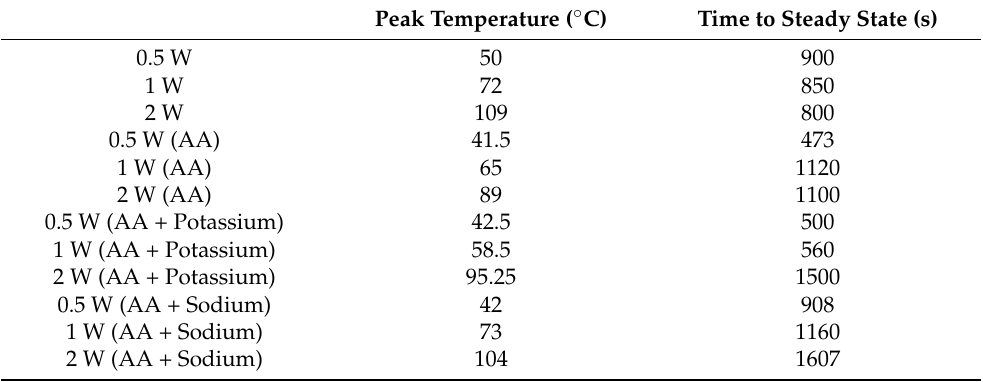
Table 3. Peak temperature and time to reach steady